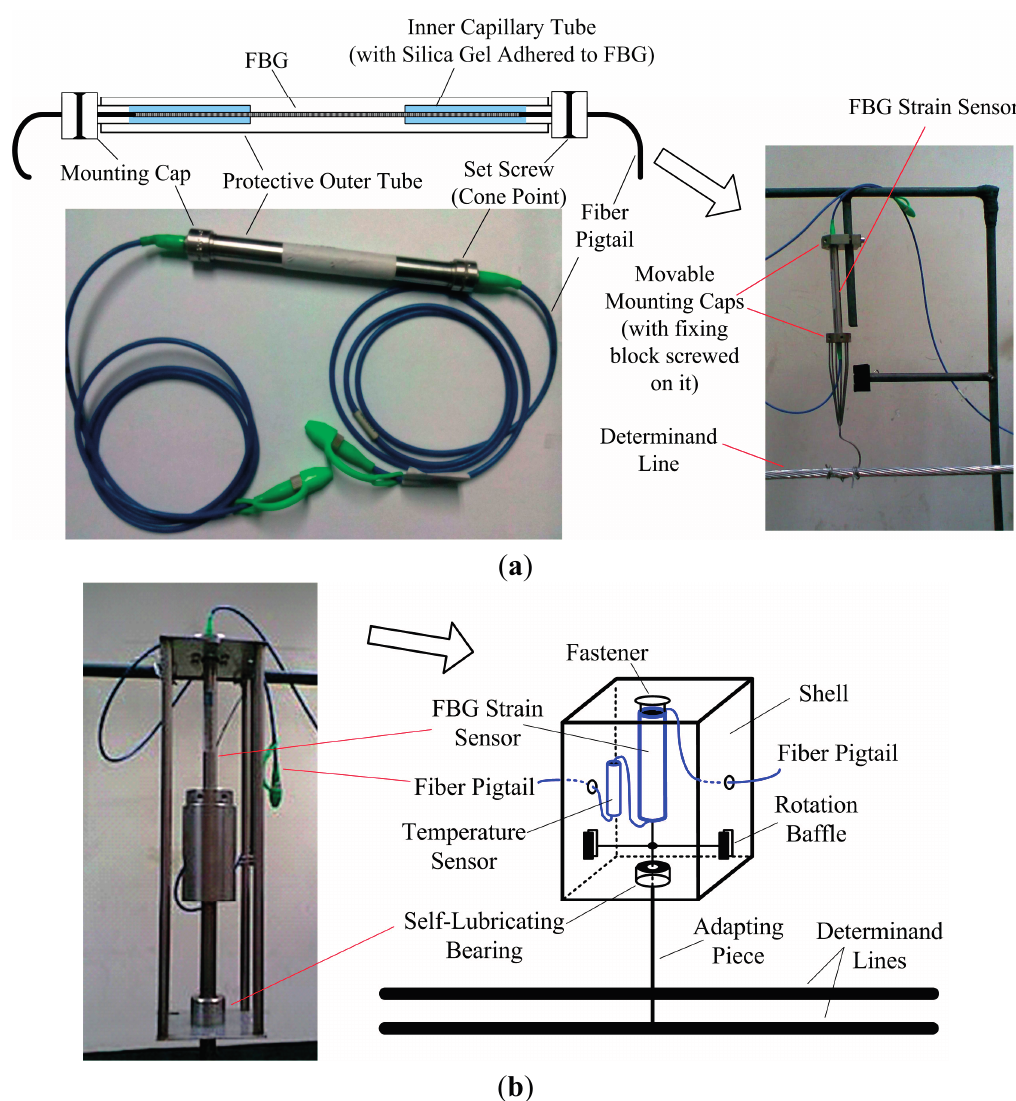
Figure 3. Structures of the FBG strain sensor ( a ) and the remote sensing unit ( b